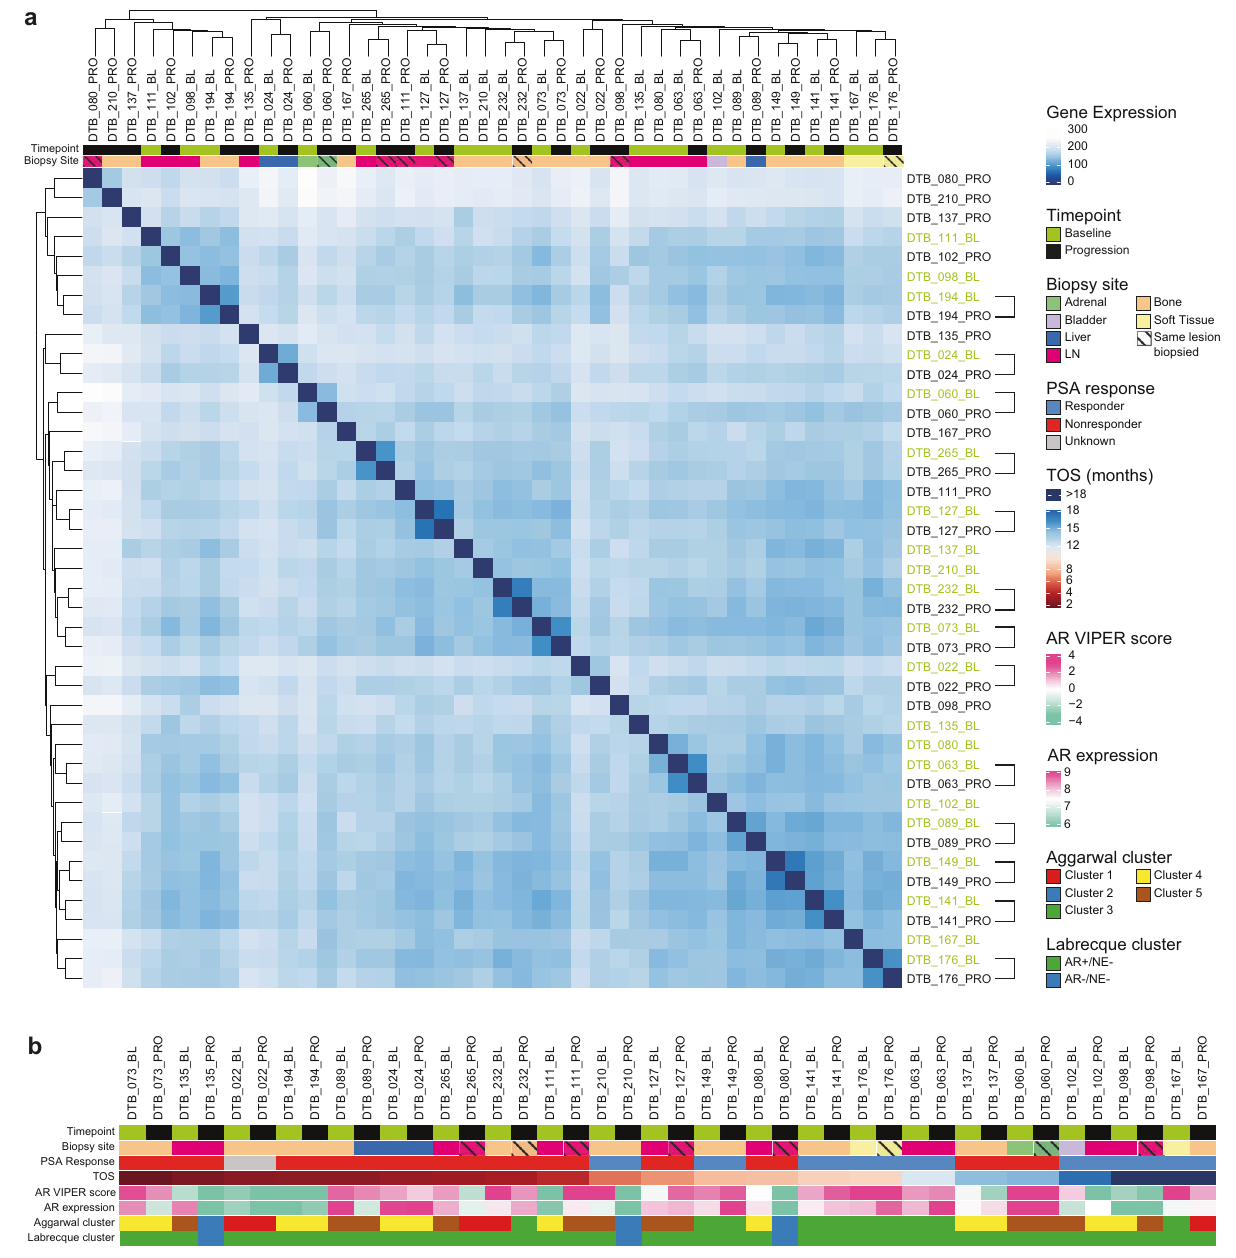
Fig. 2 | The effect of enzalutamide on tumor transcriptome is heterogenous across patients. a Similarity heatmap for all samples clustered by variance- stabilization transformation (vst). Hashes through biopsy site indicate that the same lesion was biopsied at baseline and progression. Bracket on right axis indicates that baseline and progression samples from the same patient are nearest neighbors. b Clinical and gene expression data for each matched